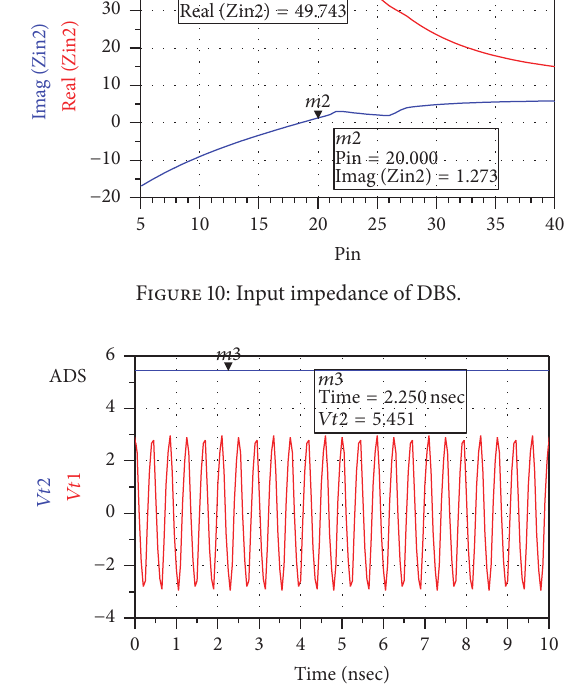
Figure 11: Output voltage of rectification circuit with 18 dBm input sinusoidal wave.